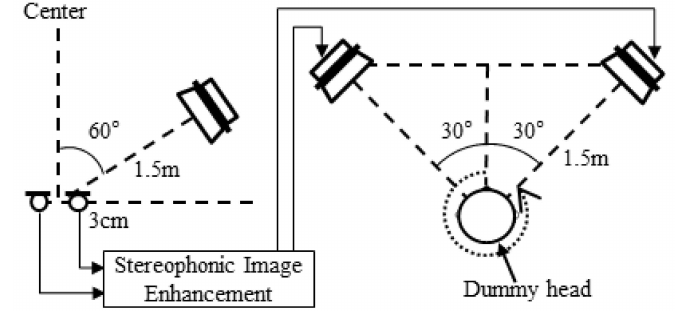
Figure 9. Experimental setup for evaluating the directivity patterns.